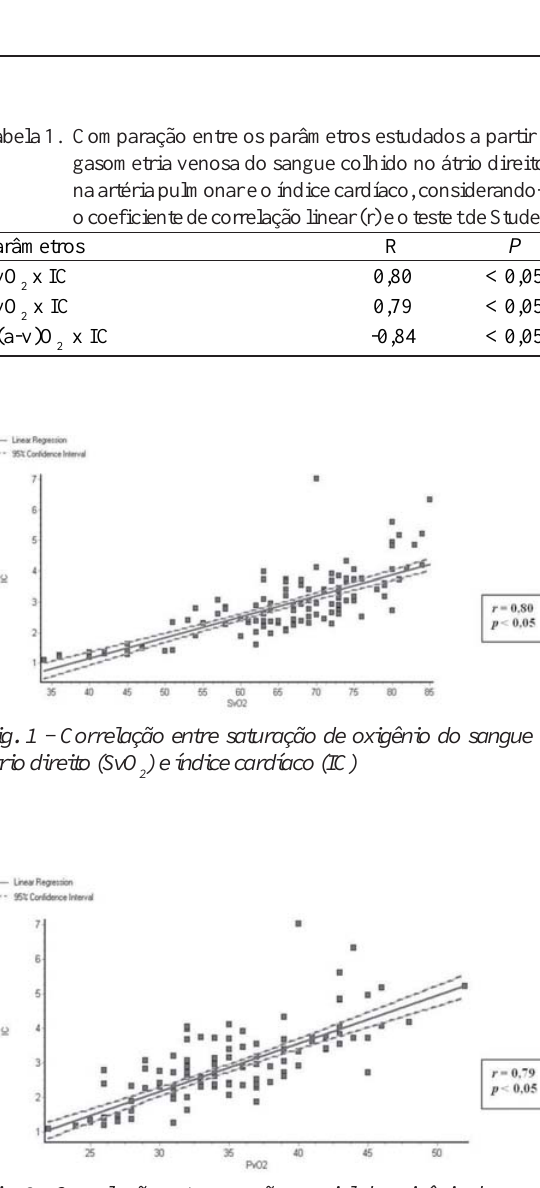
Fig. 2 - Correlação entre pressão parcial de oxigênio do sangue do átrio direito (PvO ) e índice cardíaco (IC) 2